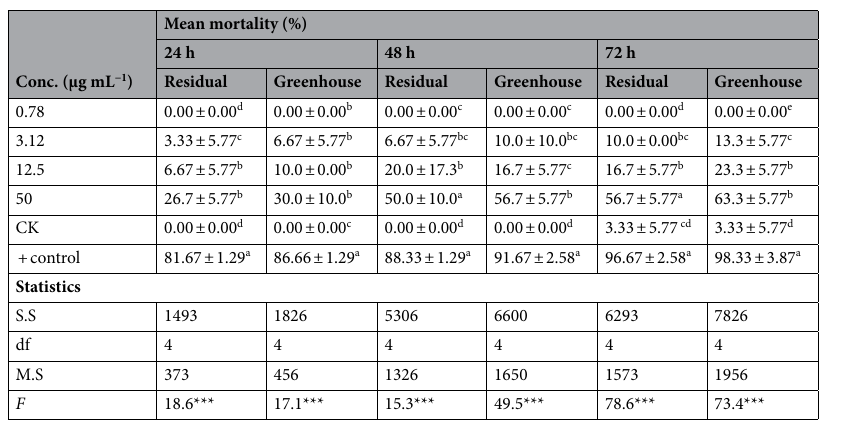
Table 4. Insecticidal activity of spinasterol and 22,23-dihydrospinasterol against Myzus persicae . Data are presented as mean ± standard deviation, and different letters indicate statistically significant differences at P < 0.05 (DMRT). S.S. sum of squares, df degrees of freedom, M.S. mean square, F F -test statistic, CK check. *** P < 0.001.